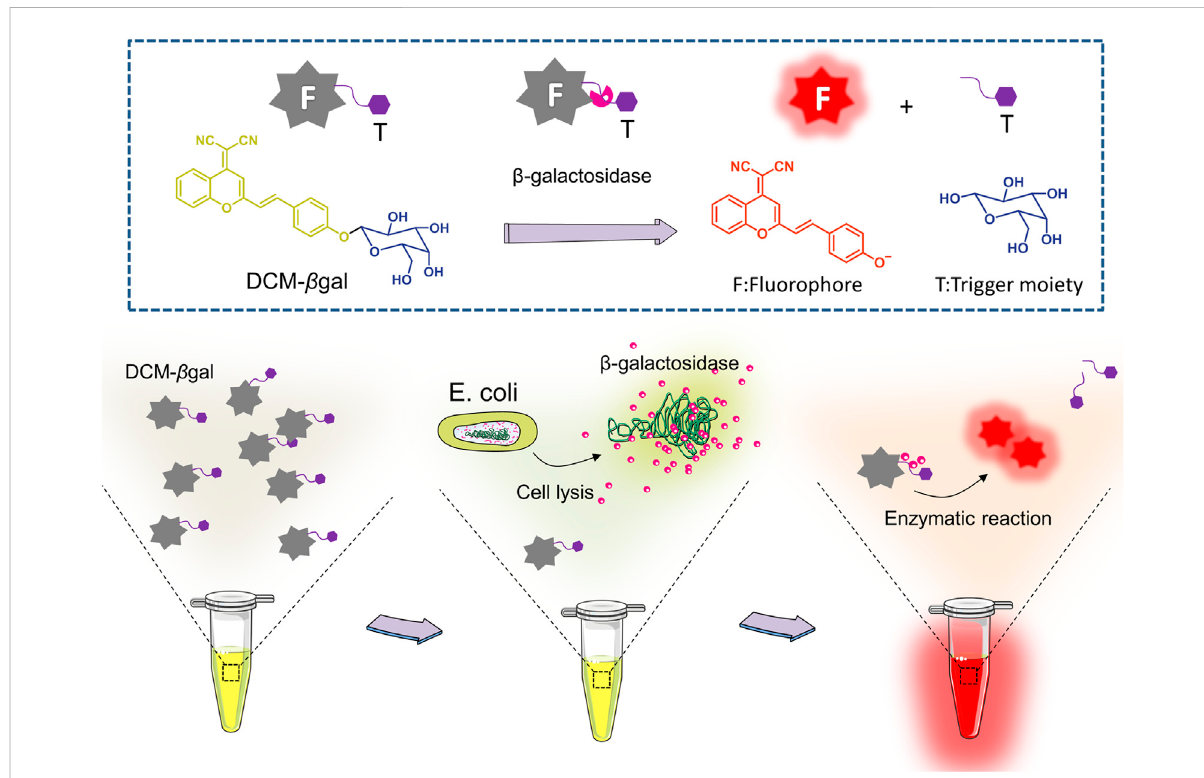
FIGURE 1 Schematic illustration of enzyme-induced probe assay for measuring of β -gal concentration and detection of Escherichia coli ( E.coli ). DCM- β gal probe consists of two parts: DCM-OH as the reporter unit and a β -gal-responsive unit. In the presence of β -gal, the responsive unit is cleaved and the DCM group shows enhance fl uorescent emission and an obvious color shift from yellow to red. For E.coli detection, the bacterial cells are lysed to release β -gal for enzymatic reaction. The concentration of E. coli cells is correlated with the colorimetric shift and the fl uorescence intensity of emission spectra